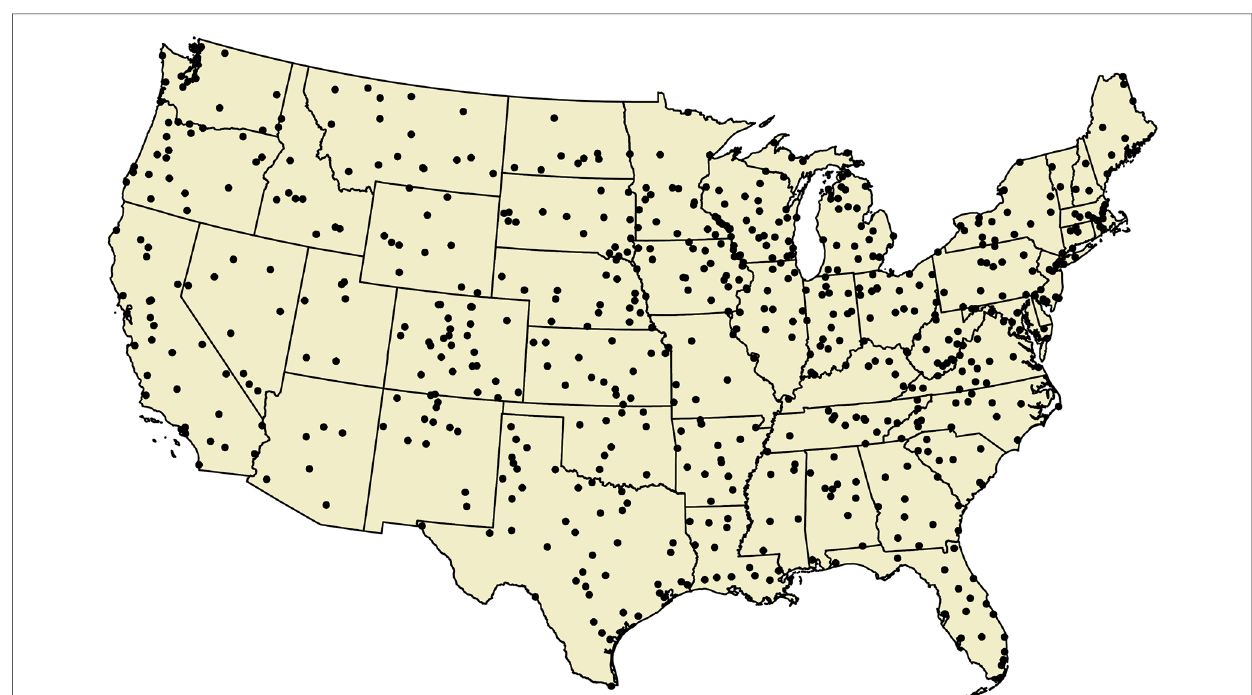
FIGURE 1 GHCN stations used in EPE threshold calculation, 1991 – 2020. Locations of GHCN stations with ≥ 99% complete daily observations in the CONUS from 1999 to 2020 included in EPE threshold